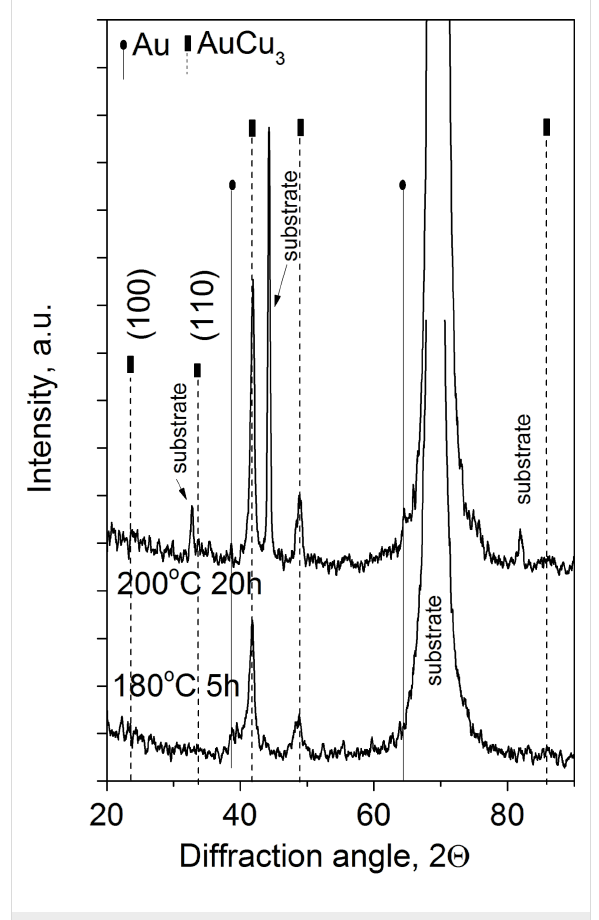
Figure 4: XRD θ –2 θ patterns of Au(10nm)/Cu(25nm) annealed samples.